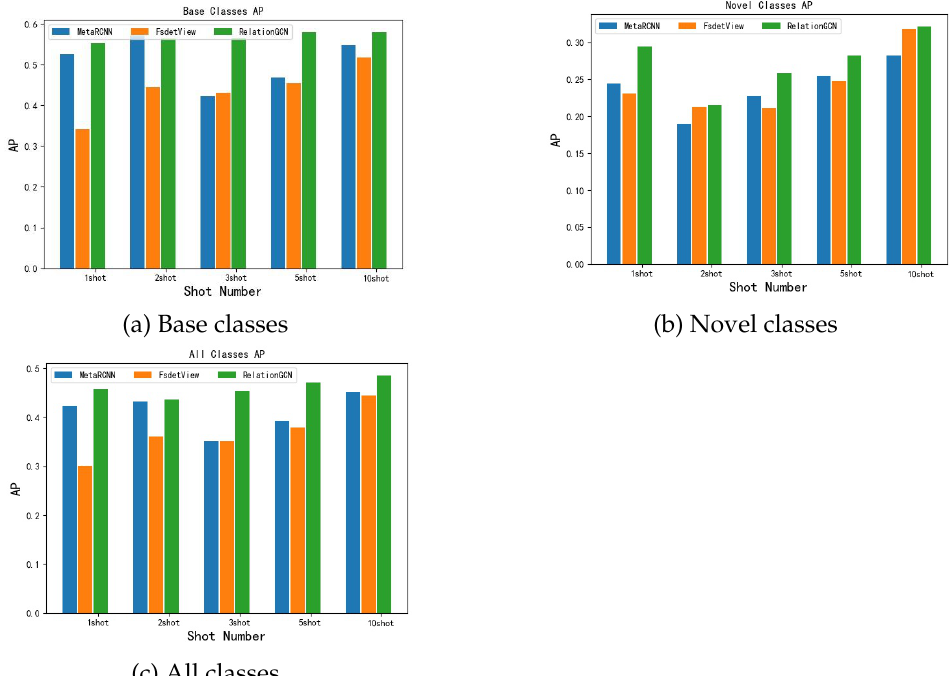
Figure 6. Performanceof different method on three type of classes under different shots. ( a ) Base classes. ( b ) Novel classes. ( c ) All classes.